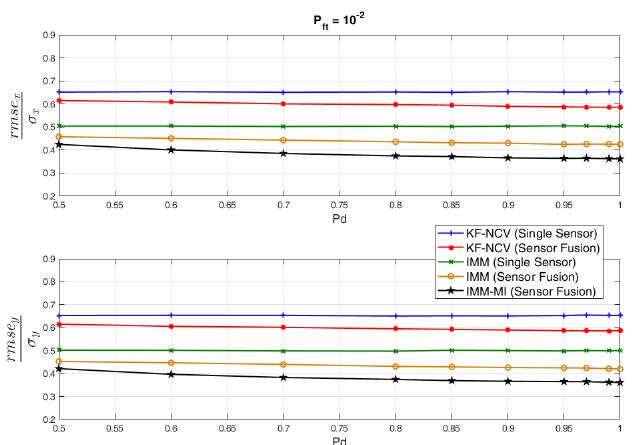
Figure 9. Comparison of the normalized positioning averaged over the entire simulation vs. P d , with respect to the x -axis (top) and the y -axis (bottom) over a simulated move-stop-move target for P ft = 10 − 2